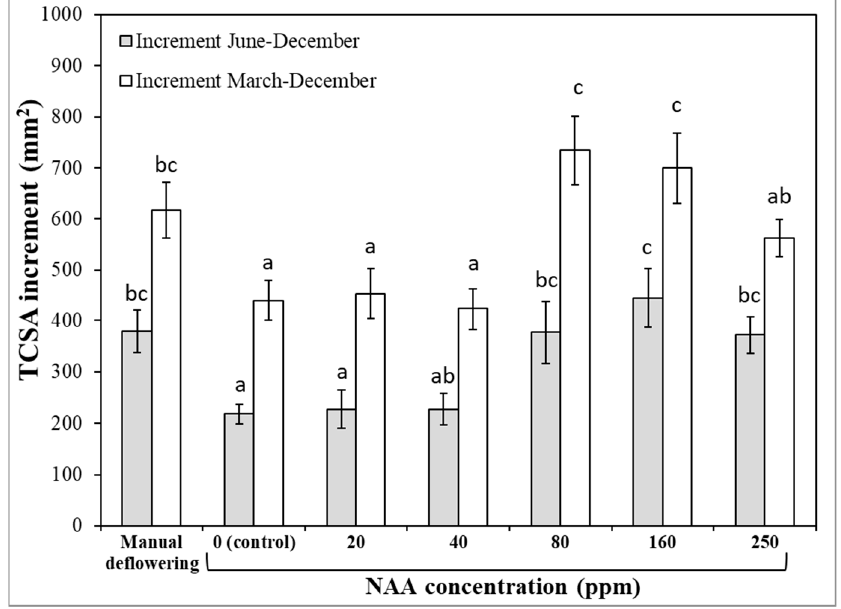
Figure 5. Increment in trunk cross-sectional area (TCSA) from the time of application of the NAA treatments (June) to the end of the season (December) and for the whole vegetative season (March– December) in control, different NAA concentrations, and manually deflowered trees in a young intensive olive orchard of the cultivar Moraiolo. Values are means of 4 replicates per treatment, and bars represent standard errors. Different letters indicate significant differences between treatments within each period (June–December and March–December, respectively) according to the Student– Newman–Keuls Test ( p < 0.05).